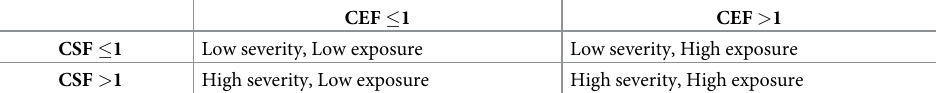
Table 3. Classification criteria for combinations of road-weather conditions to identify road-weather conditions with intensified safety